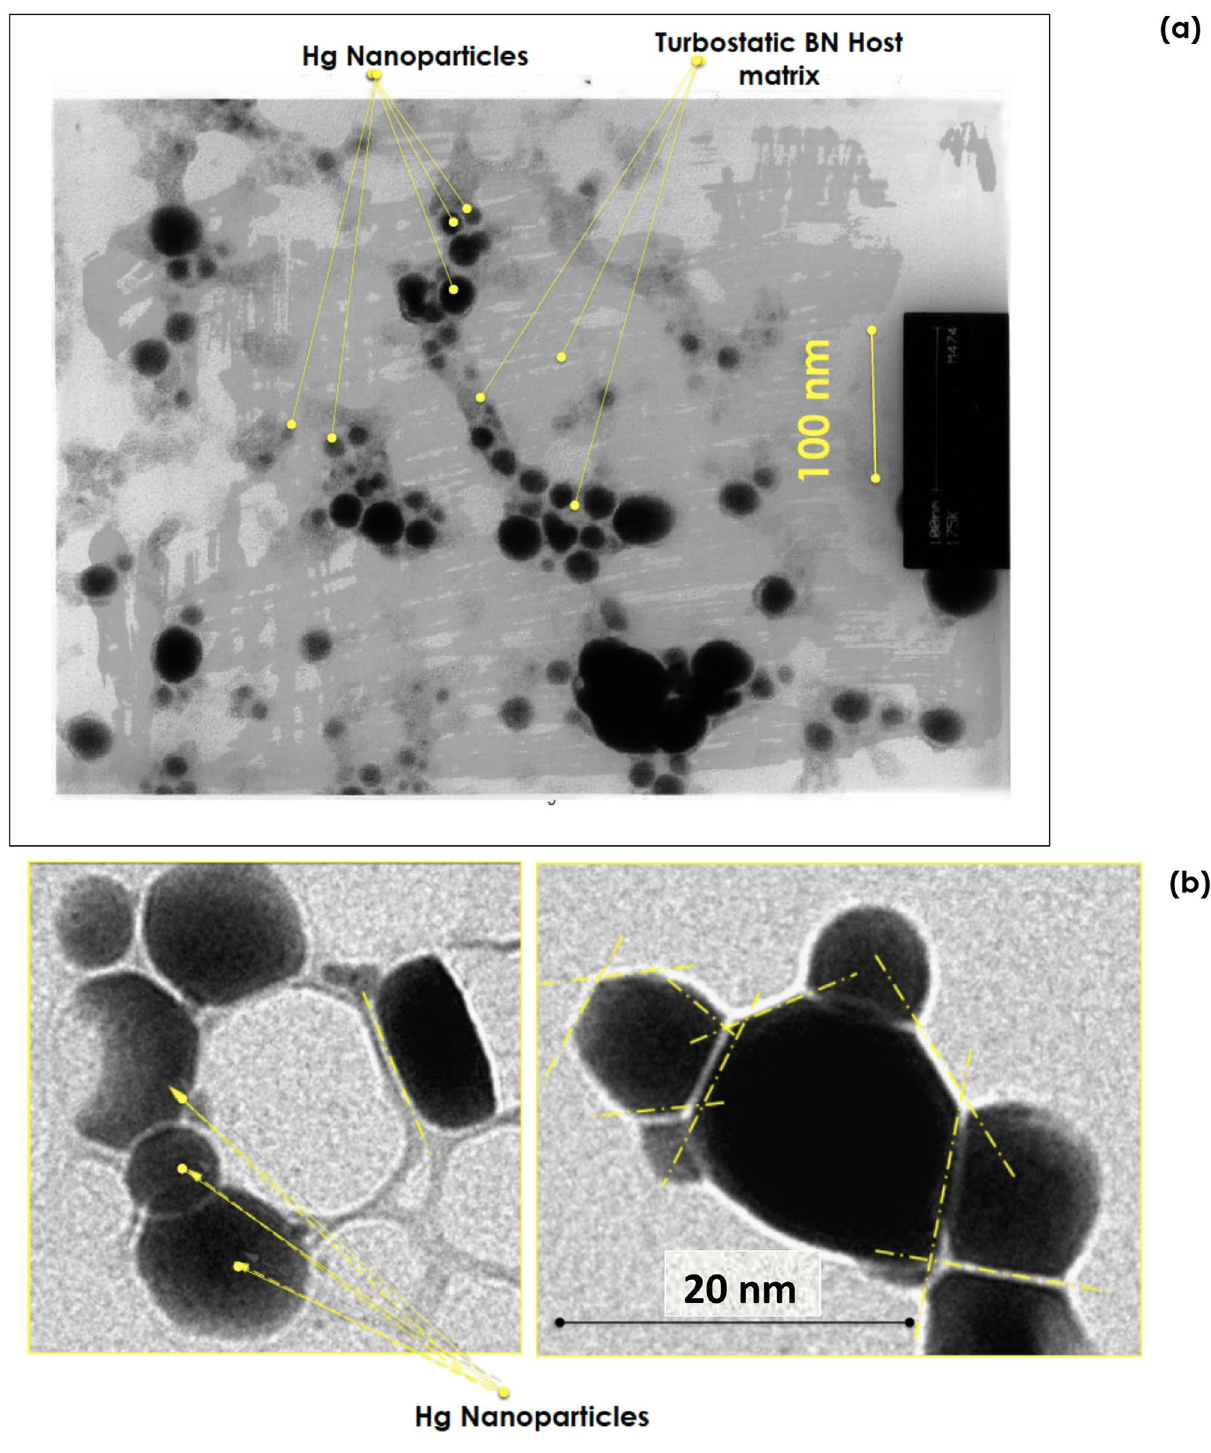
Figure 2. ( a ) Low and ( b ) High magnification Transmission Electron Microscopy of the Hg 1/20 -BN nanocomposite with an early stage average size of the Hg nanoparticles 〈 Ø Hg 〉 TEM ~ 2.4 nm dispersed in the turbostratic BN matrix of the Hg 1/20 -BN